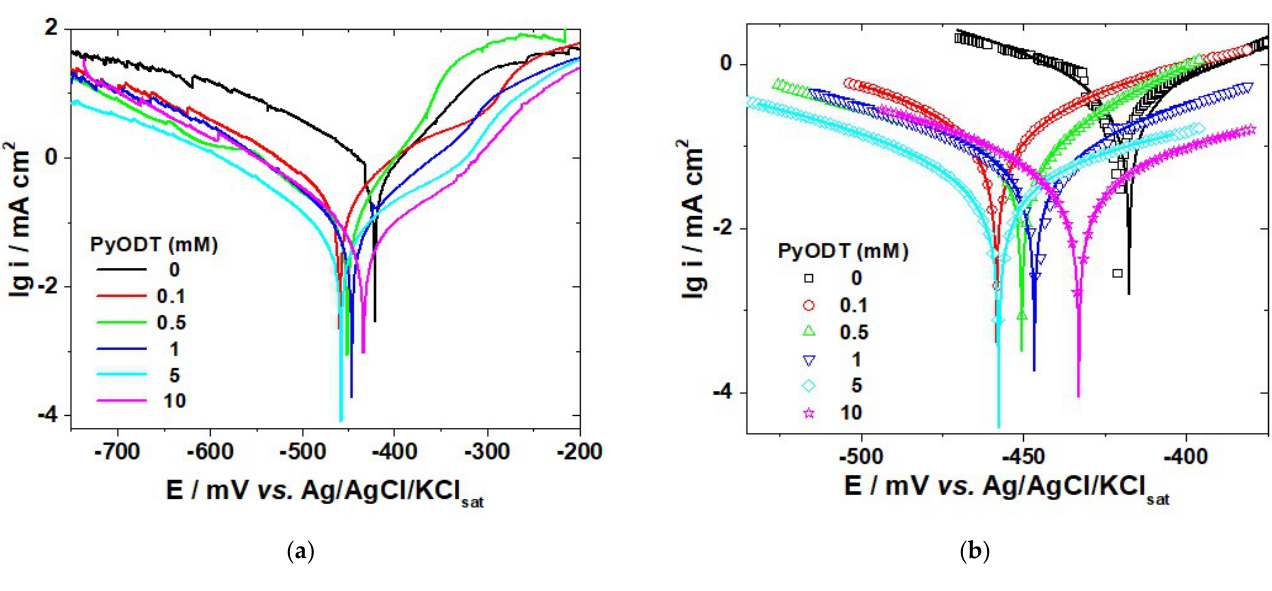
Figure 2. ( a ) Polarization curves of C-steel in 1.0 M HCl solution in the absence and the presence of different concentrations of PyODT.; ( b ) Comparison of the experimental and fitting data using a non-linear fitting procedure. Symbols = experimental data and lines = calculated data.